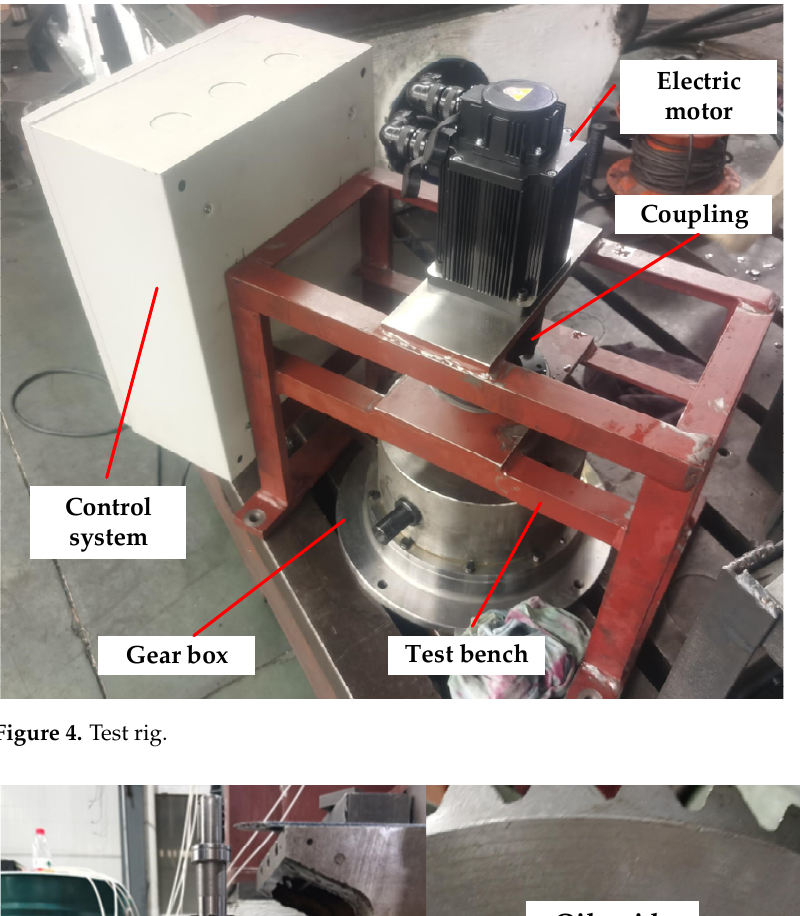
Figure 4. Test rig.